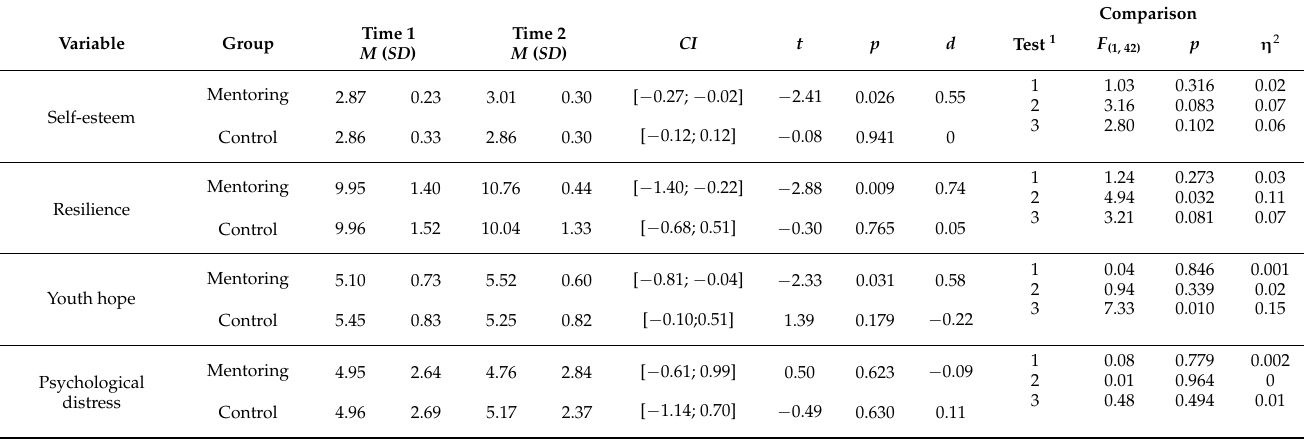
Table 2. Participation in the mentoring program and well-being outcomes: descriptive statistics, repeated measures ANOVA with between-subject (group) effect, and paired t -tests per